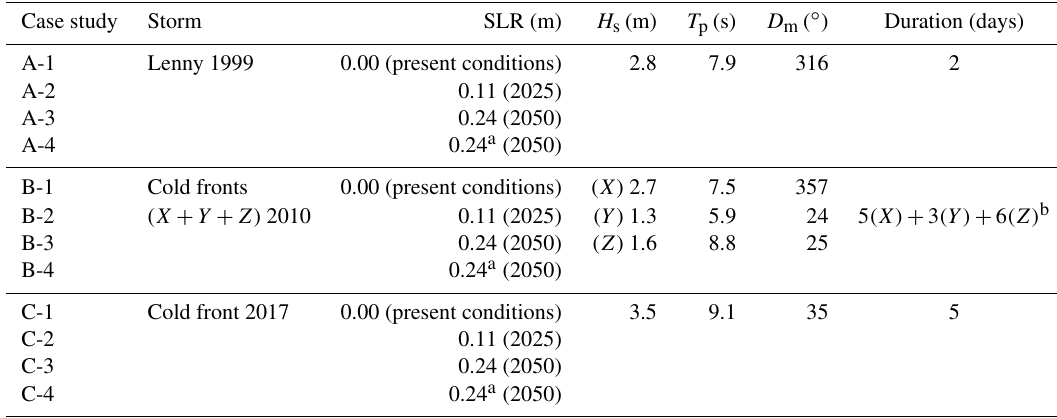
Table 5. Evaluation of flooding through numerical modeling of Bocagrande Beach.